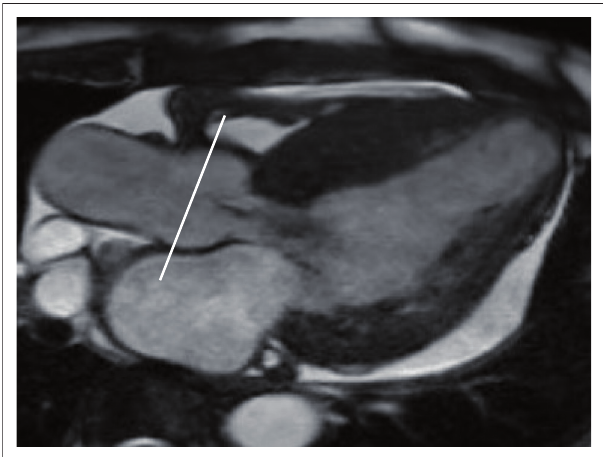
FIGURE 12: LVOT SSFP image demonstrates the orientation of the phase contrast image for the aorta (white line).